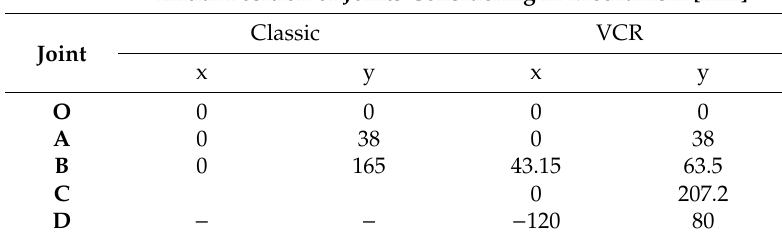
Table 1. Kinematic input data.